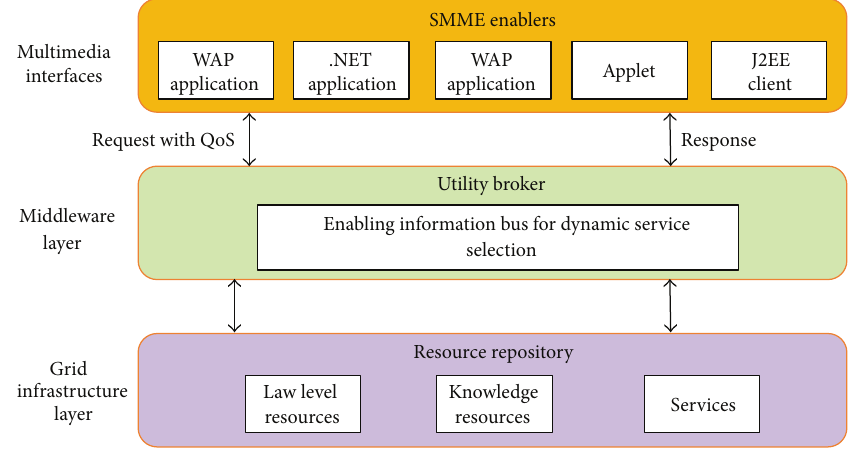
Figure 1: GUISET